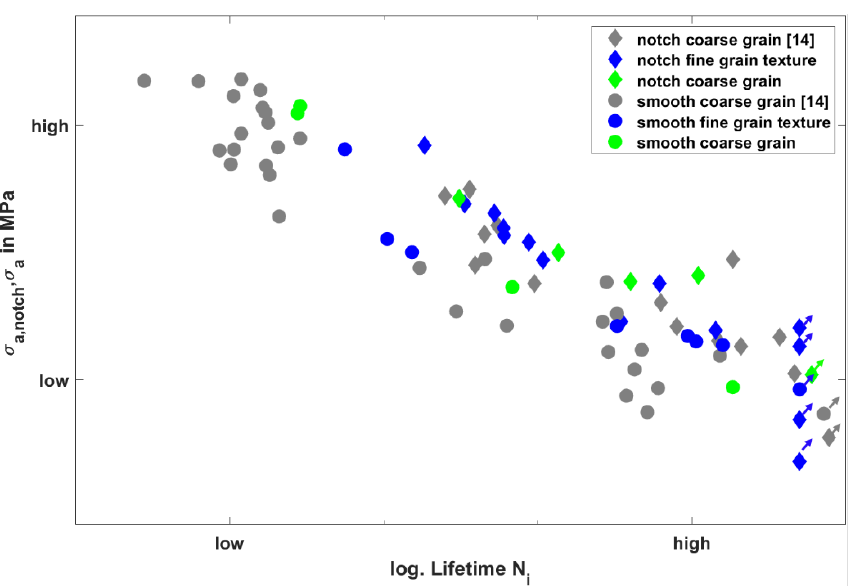
Figure 6. Stress amplitude Wöhler curve for smooth and notched specimen with different grain orientation distributions.